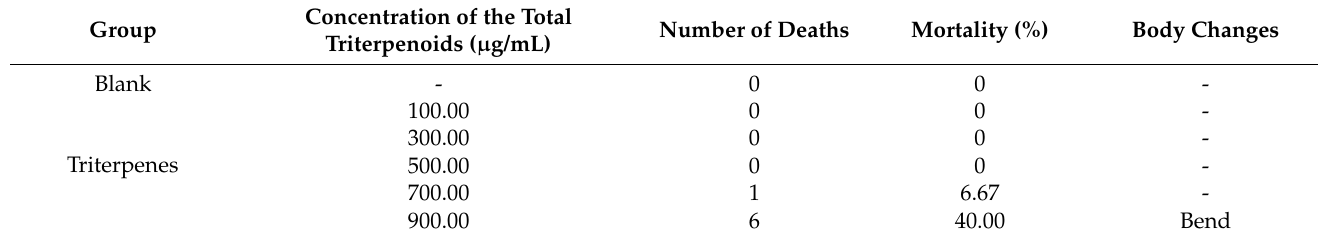
Table 2. The results for the MTC.